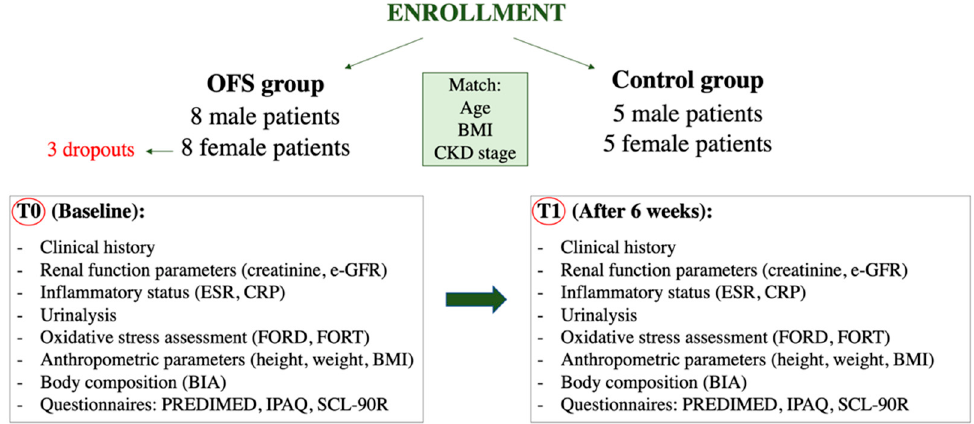
Figure 1. Flow-chart of in vivo pilot study. Abbreviations: BIA, bioelectrical impedance analysis; BMI, Body mass index; CKD, Chronic kidney disease; CRP, C reactive protein; e-GFR, Estimated-glomerula filtration rate; ESR, Erythrocyte sedimentation rate; FORD, Free oxygen radical defense; FORT, Free oxygen radical test; IPAQ, International physical activity questionnaire; OFS, Oral food supplement; PREDIMED, Prevención con Dieta Mediterránea; SCL-90R; Symptoms checklist- 90 revised.